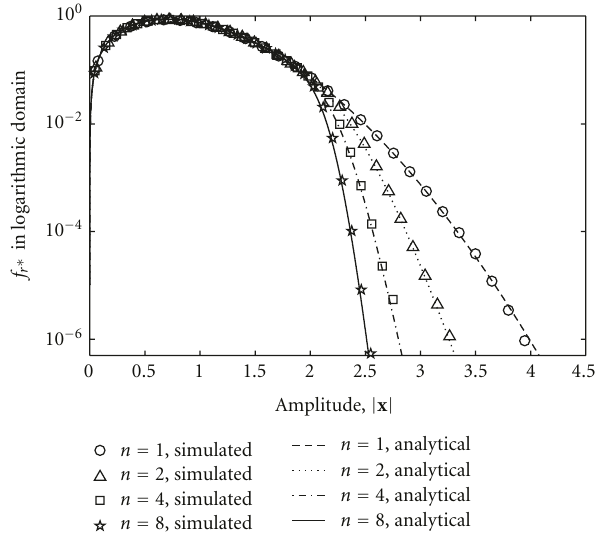
Figure 2: Analytical and simulated logarithmic PDF for f r ∗ ( x ) corresponding to N = 128.